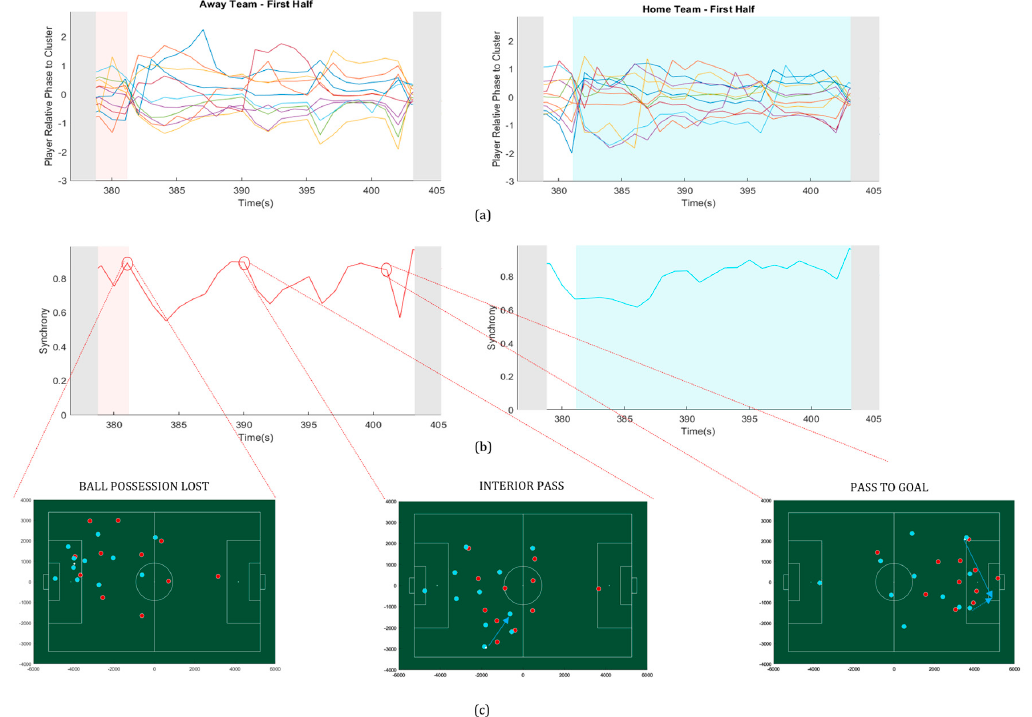
Figure 4. Variations of the order parameter (synchronization) and the player relative phase to the team, during a specific time frame (30 s) in the first half of the match. ( a ) Relative phase of each player to the team, in both teams; ( b ) synchrony (´ r ) measures for each team. The grey background indicates that the game is not running. Red or blue background indicate when the away team (red) or the home team (blue) have possession of the ball and white background indicates that the team does not have possession of the ball; ( c ) exemplar key events of the match that are expressed by three apexes of the synchronization values, circled in red on the left-side (away